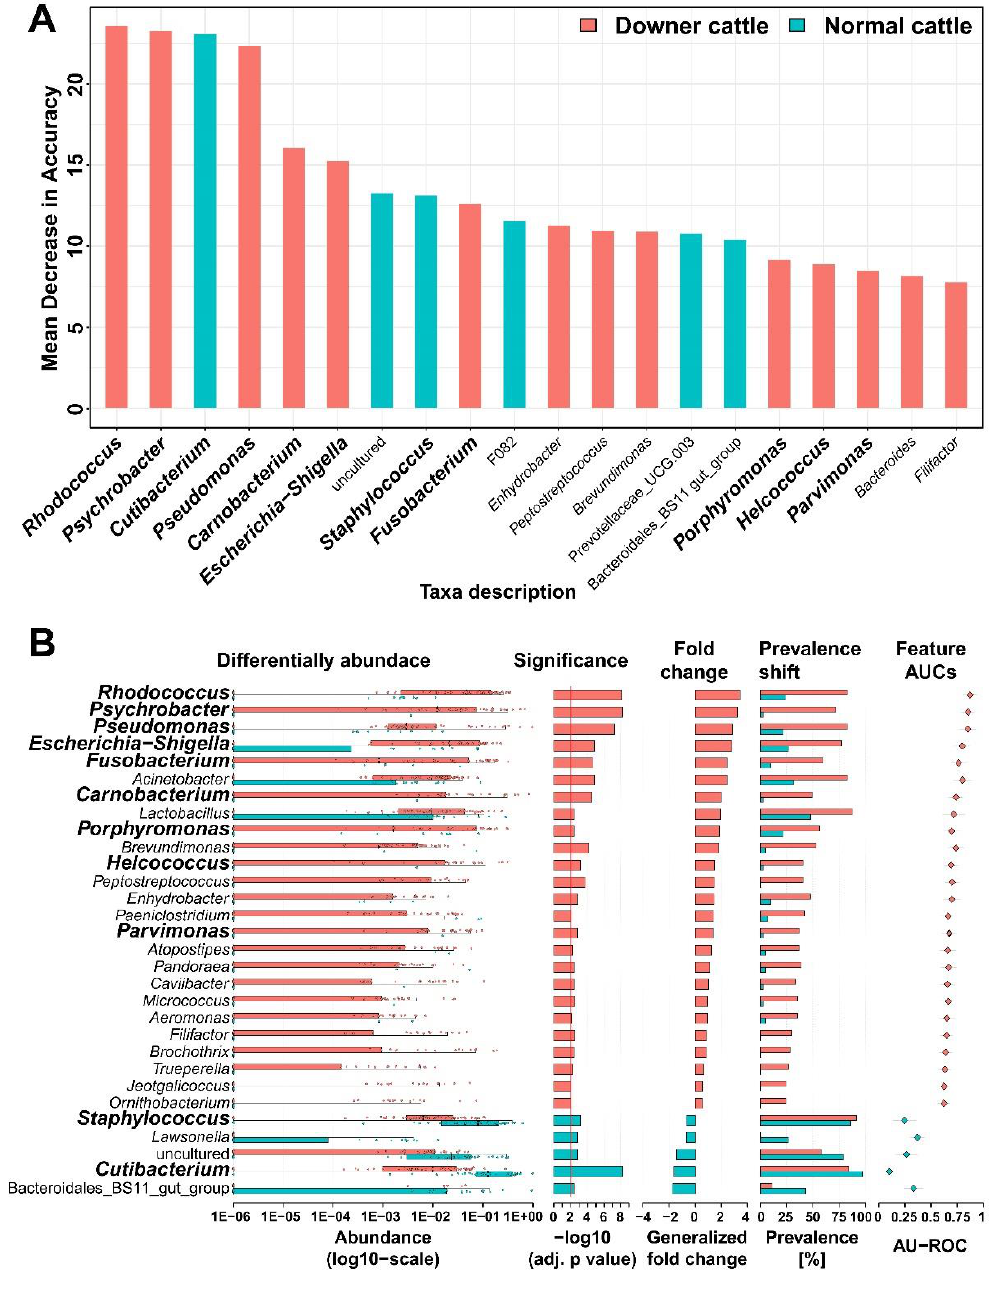
Figure 2. Investigation of the representative genus based on the downer and normal cattle’ s micro- biota. The genera written by bold character were detected in feature selection by Random Forest regression and a difference of their abundance in the microbial community at once. ( A ) Feature selection through Random Forest regression. ( B ) Association of the representative genus and its sample group through confirmation using association function in the SIAMCAT R package.